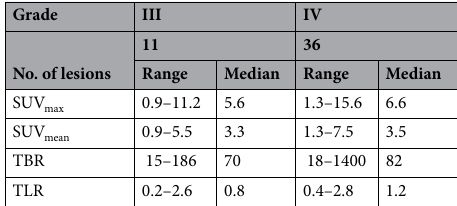
Grade III IV No. of lesions